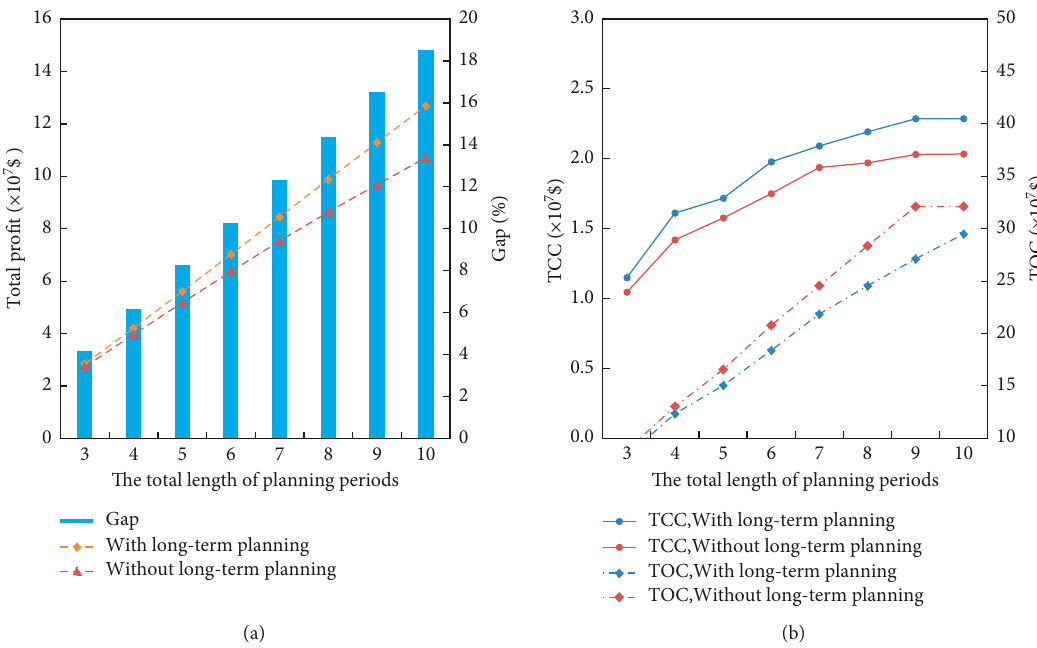
Figure 20: System performance with and without long-term planning in the Sioux Falls